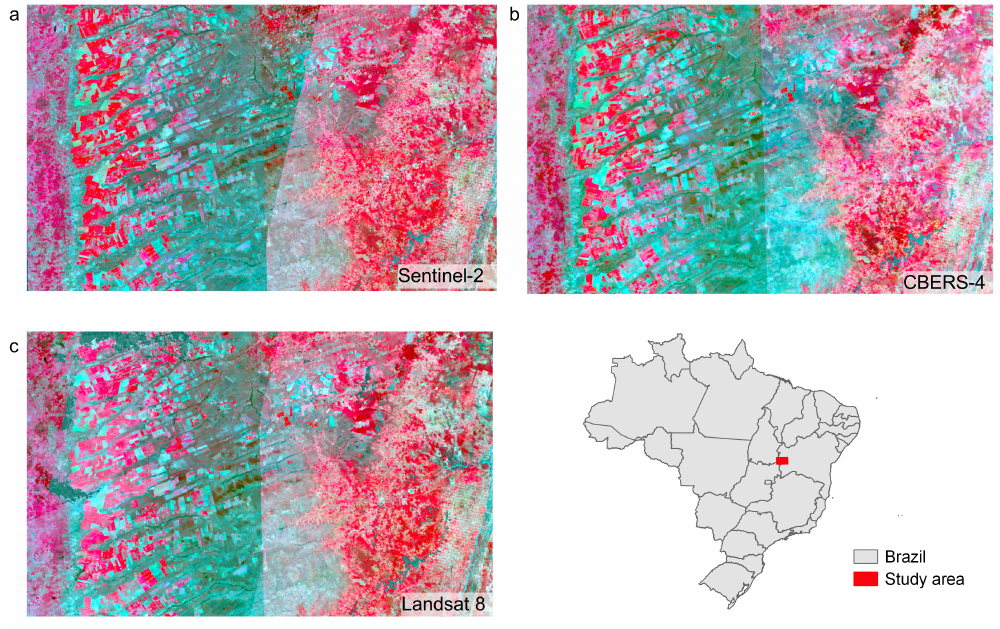
Figure 10. ( a ) Sentinel-2, ( b ) CBERS-4, and ( c ) Landsat-8 data cube images of the study area in January